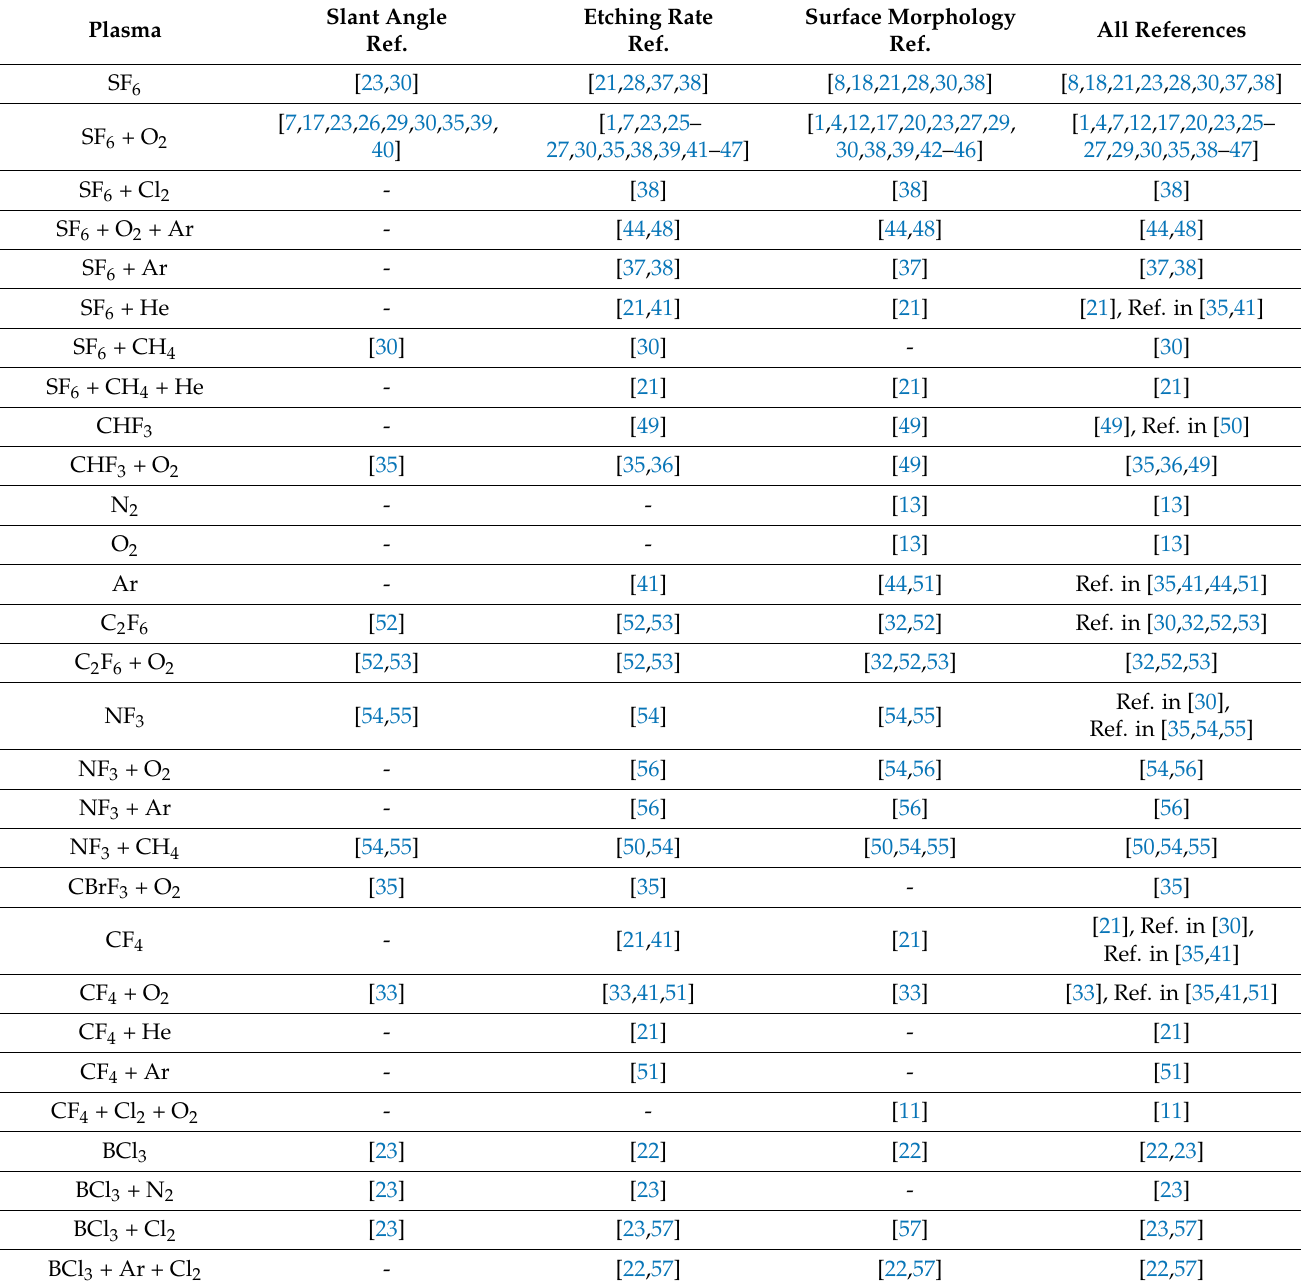
Table 1. Various plasmas used in the ICP-RIE processes and the main experimental aspects (slant angle, etching rate, and surface morphology) of the SiC